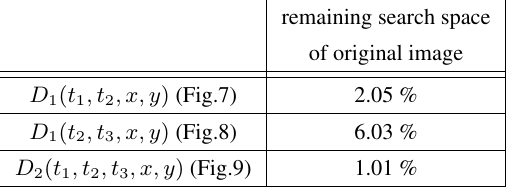
Table 1: Limited search space due to motion mask remaining search